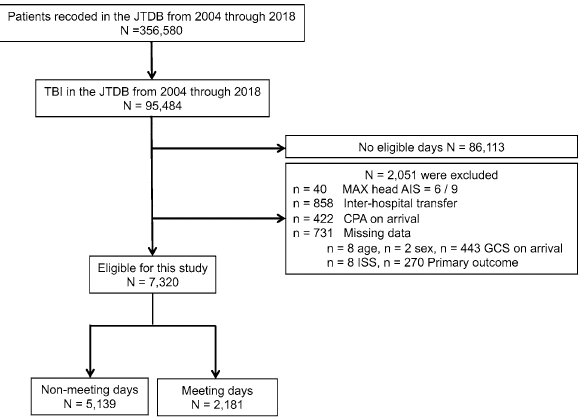
Figure 1. Flow chart of patients included in this study. JTDB Japan trauma data bank, AIS abbreviated injury scale, CPA cardiopulmonary arrest, GCS glasgow coma